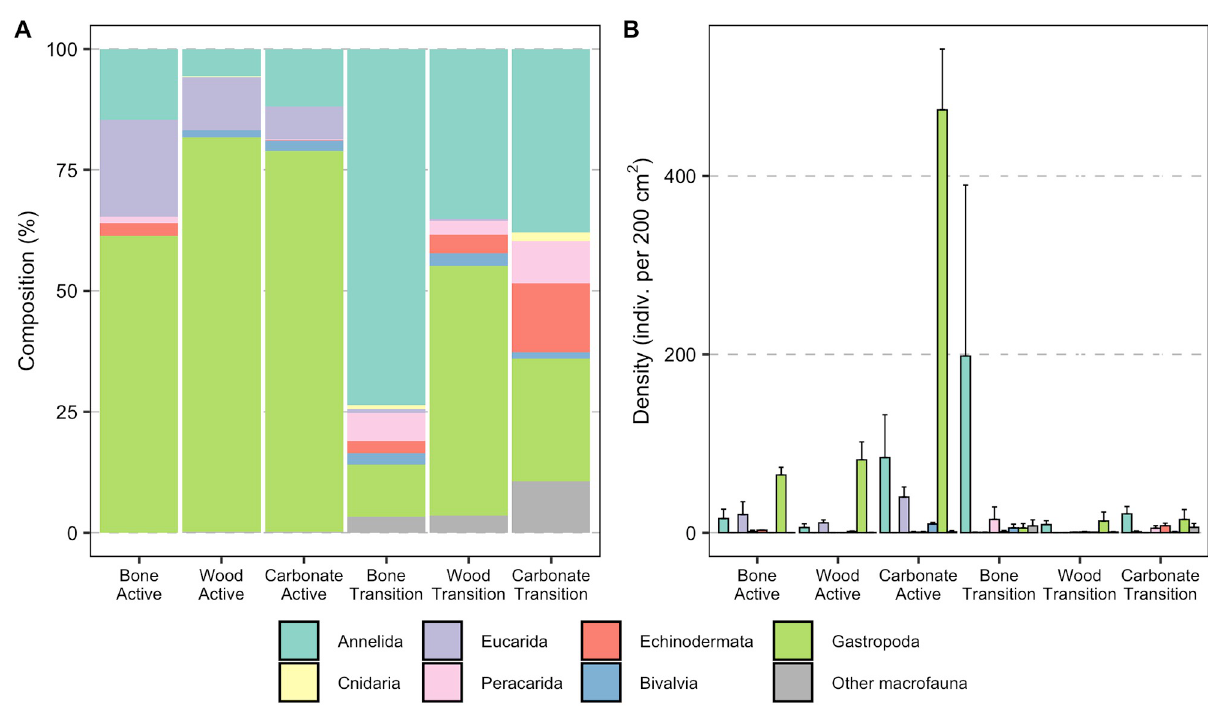
Fig 5. Community composition and density of macrofaunal colonizers on the experimental substrates. (A) Composition (%) and (B) average density (indiv. per 200 cm 2 ) of macrofaunal invertebrates on experimental bone, wood, and carbonate rock deployed for 7.4 years (2010–2017) at active and transition sites at Mound